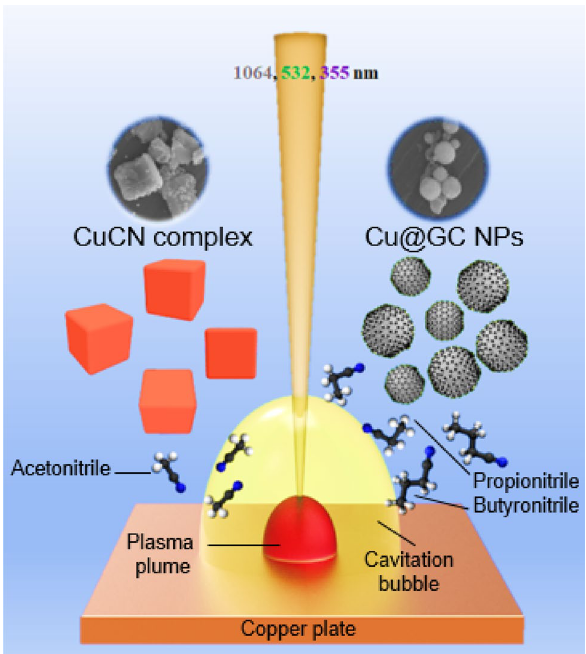
Figure 1. PLAL (1064, 532, and 355 nm) of a Cu target in various nitrile solvents (acetonitrile, propionitrile, or butyronitrile) leading to the formation of cubic CuCN and spherical